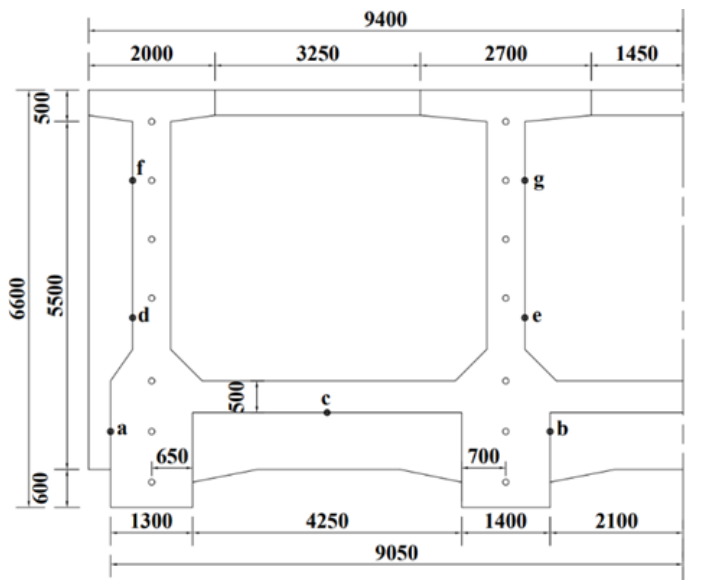
Figure 5. Locations of the characteristic points.